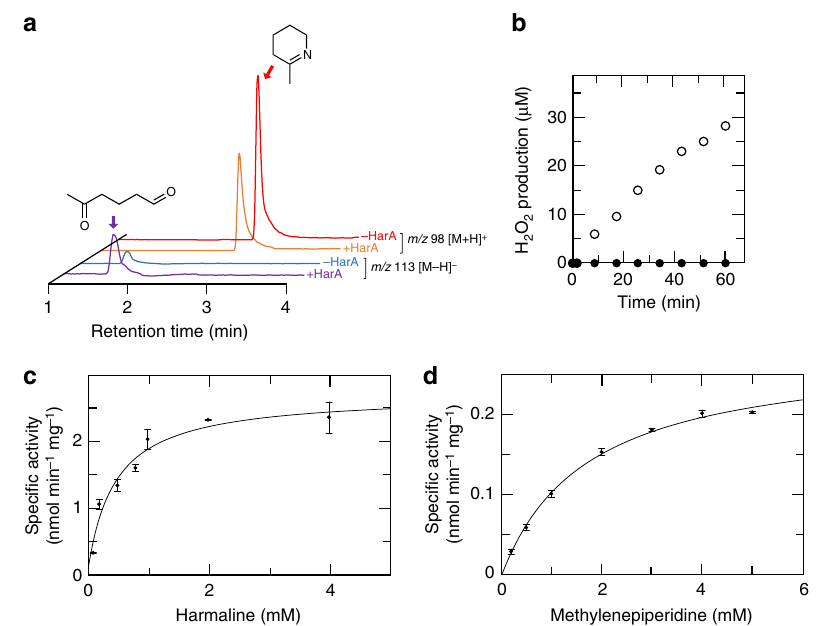
Fig. 4 Substrate speci fi city and kinetic properties of HarA. HarA catalyzed ring-opening reaction of cyclic imine within 2-methylenepiperidine (MP). a After incubation with HarA, MP was converted into the reaction product (5-oxohexanal), which exhibited a m/z value of 113 [M − H] − . b Time-dependent H 2 O 2 production during incubation of MP with or without HarA (shown in empty or fi lled circles, respectively) was measured by the DAOS method (described under Methods). Michaelis – Menten analyses were performed using c harmaline or d MP as the substrate. All data points in c and d represent the mean values ± S.E.M. for three experiments. Source data are provided as a Source Data fi